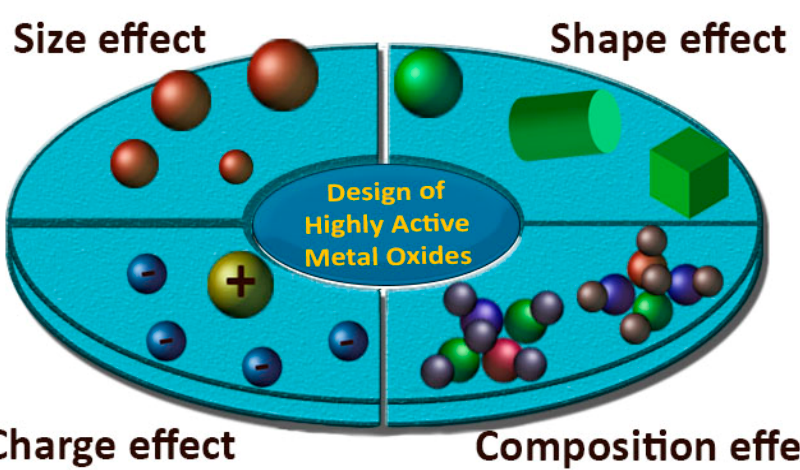
Figure 5. Schematic illustration of metal oxides (MOs) fine-tuning through modification of their size, shape, composition and electronic/chemical state.